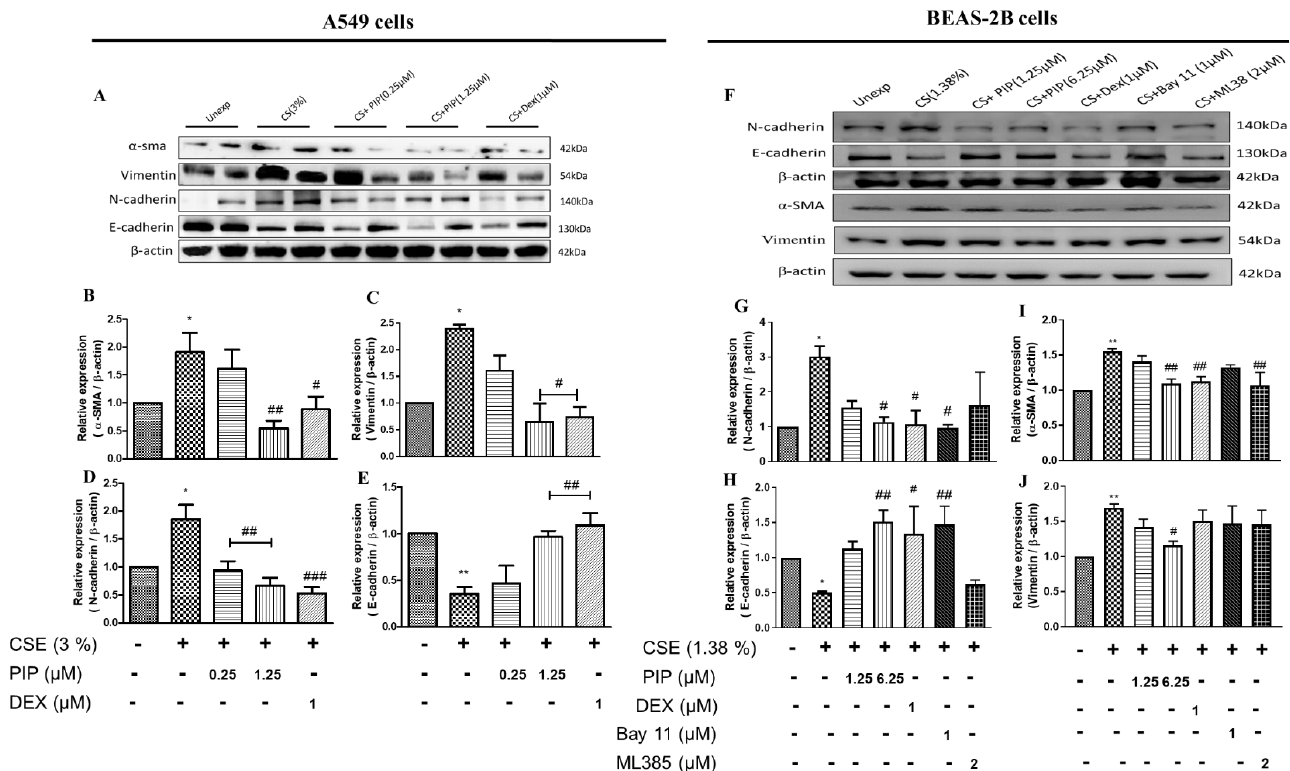
Figure 4. Effect of piperine treatment on expression of EMT signaling in CSE-exposed airway cells. ( A ) Immunoblot images representing the expressions of E-cadherin, N-cadherin, Vimentin, and α -SMA in A549 cells. Bar graphs representing densitometry analysis of ( B ) E-cadherin, ( C ) Vimentin, ( D ) E-cadherin and ( E ) α -SMA. ( F ) Immunoblot images representing the expressions of E-cadherin, N-cadherin, Vimentin and α -SMA in BEAS-2B cells. Bar graphs representing densitometry analysis of ( G ) N-cadherin, ( H ) E-cadherin. ( I ) α -SMA and ( J ) Vimentin. The values are expressed as mean ± SEM ( n = 3). * p < 0.05 and ** p < 0.01, # p < 0.05, ## p < 0.01 and ### p < 0.001 vs. CSE. For A549 cells: CSE: cigarette smoke extract-treated (3%), CS + PIP (0.25): cigarette smoke extract + 0.25 µ M PIP, CS + PIP (1.25): cigarette smoke extract + 1.25 µ M PIP, CS + DEX (1): cigarette smoke extract + 1 µ M DEX. For BEAS-2B cells: CSE: cigarette smoke extract-treated (1.38%), CS + PIP (1.25): cigarette